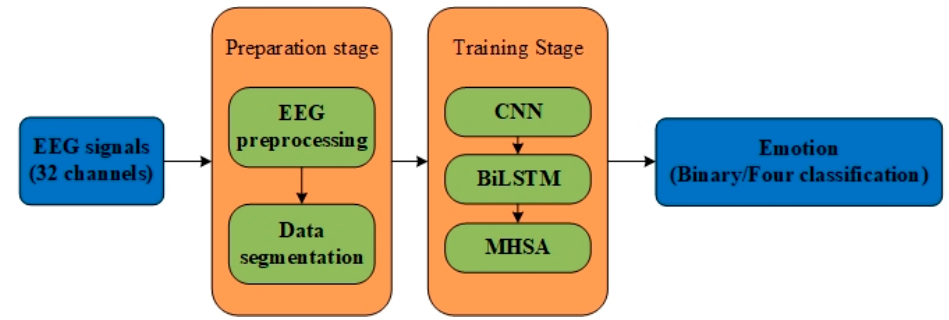
Figure 6. CNN-BiLSTM-MHSA training